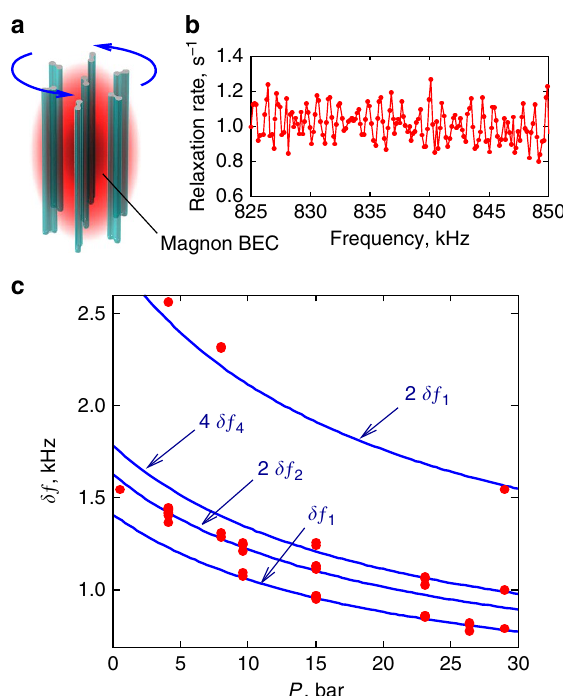
Figure 4 | Excitation of acoustic magnons by vortices. ( a ) Schematic plot of vortices in rotating 3 He-B. Precession of magnetization of the magnon condensate causes oscillations of non-axisymmetric vortex cores. The oscillations produce acoustic magnons and increase relaxation of the condensate. ( b ) Relaxation rate of the magnon condensate as a function of frequency, measured at O ¼ 1rads (cid:3) 1 and P ¼ 23.4 bar. Two sets of acoustic magnon resonances with periods B 1kHz produce a clearly seen beat with a period of 5kHz. ( c ) Measured periods of magnon condensate relaxation peaks (symbols) as a function of pressure. Lines are plotted using equation (2) for acoustic magnon resonances without fitting